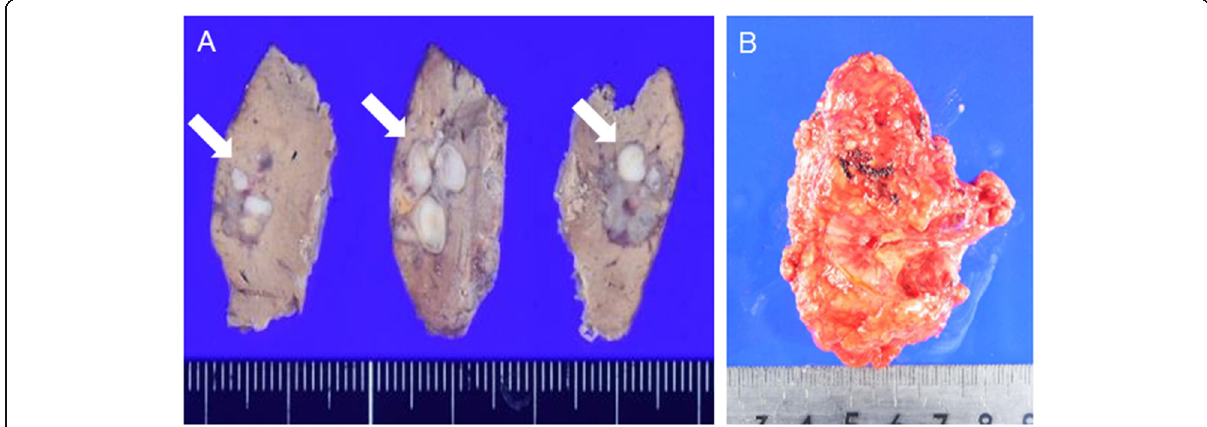
Fig. 2 Histopathological examination of the resected specimen. a The resected liver specimen showing a gray-white multinodular shape tumor (arrow). b The resected specimen of the right adrenal grand with IVC tumor thrombus (arrow